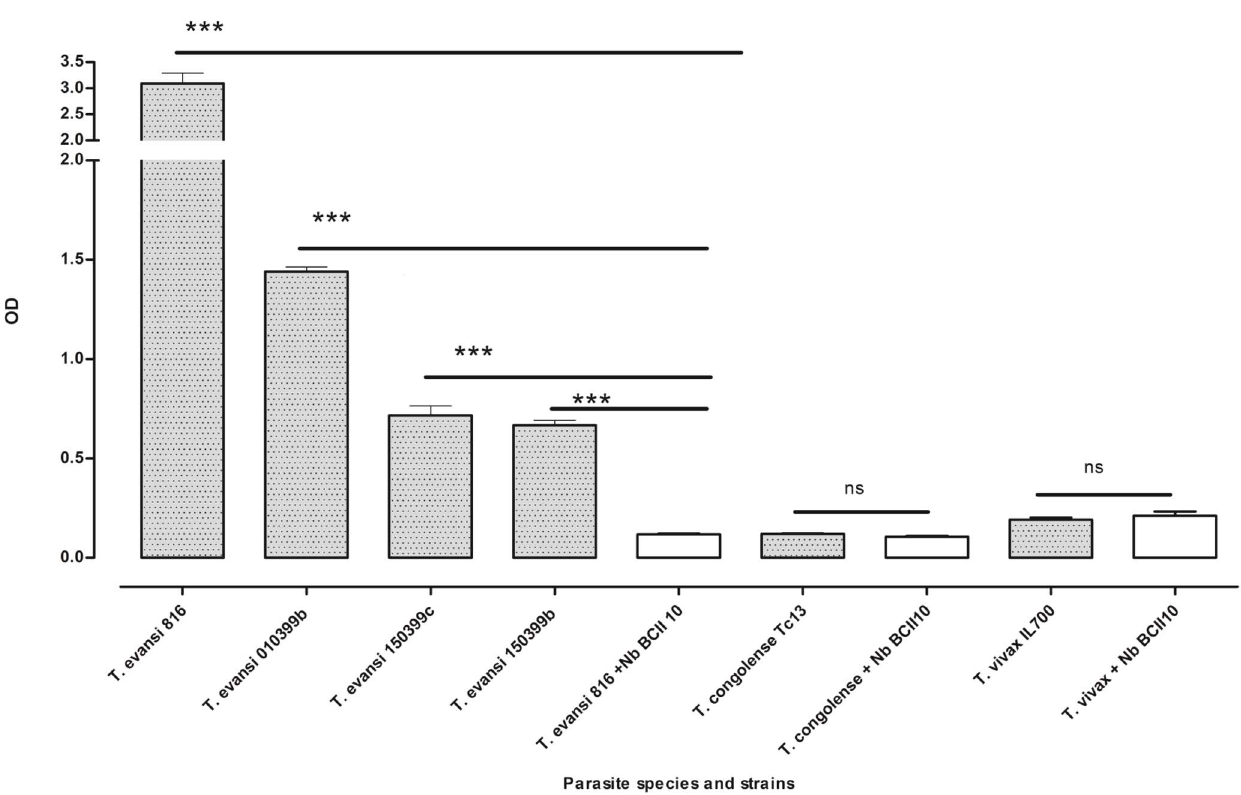
Fig. 2. Solid-phase ELISA result. Coating 5 m g/well of soluble protein of parasite lysates ( T. evansi strains, T. congolense and T. vivax ) and subsequent recognition by Nb392 and non-relevant nanobody (NbBCII10) as negative control. In each of three separate experiments, lysates were plated in triplicates and detected with Nb392 (shaded boxes) or NbBCII10 (unshaded boxes). Data presented are mean values of three wells ( ¡ SD). The mean values of negative control wells are compared to the mean values of corresponding test wells coated with lysates of T. evansi strains, T. vivax and T. congolense , * P , 0.05, ** P , 0.01, *** P , 0.001. Results shown are representative of three independent experiments.